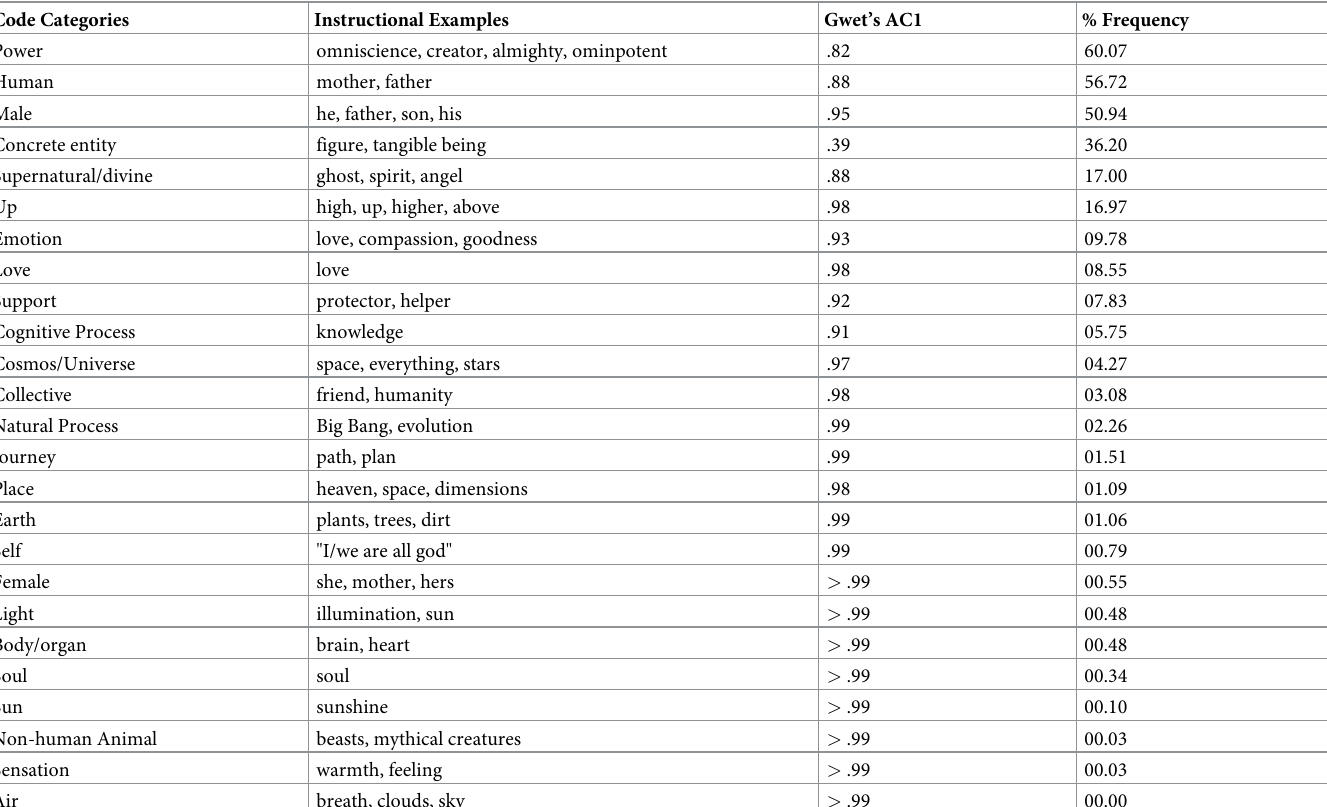
Table 1. Code categories, examples, interrater reliability, and percentage of the sample that used each metaphoric source category. Code